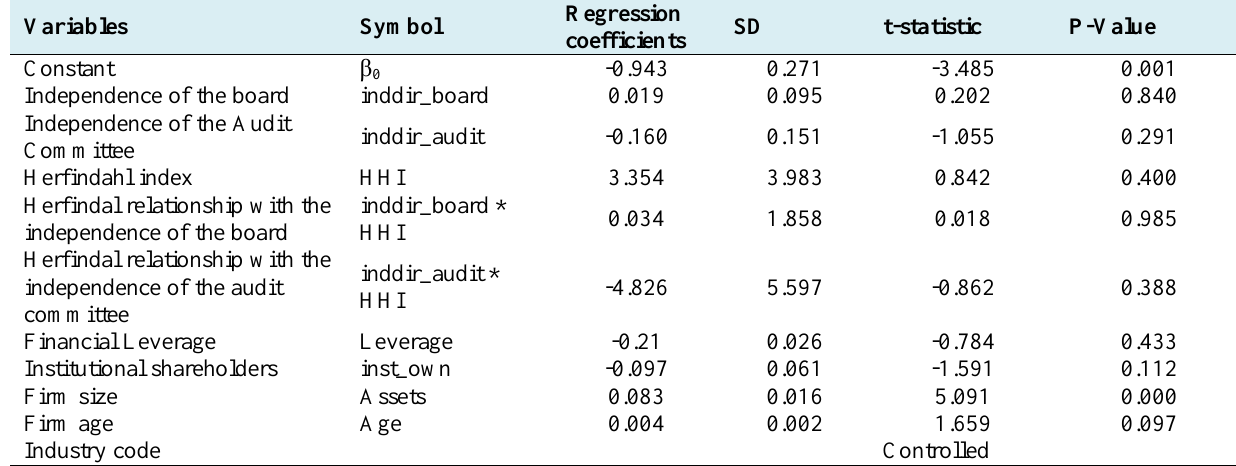
Table 8. Results of fitting the model related to the fourth criterion of opinion shopping (a simultaneous increase of audit fee and increase of discretionary accruals this year compared to that in the previous